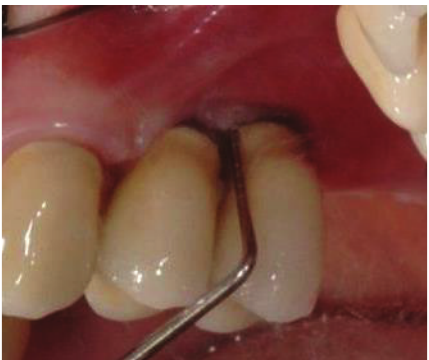
Figure 10: The mucoperiosteal flap was repositioned to ensure transmucosal healing and proper wound closure.